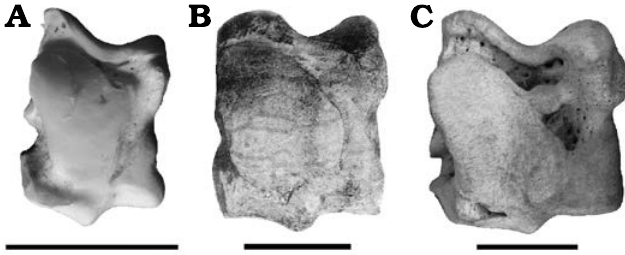
Fig. 8. Astragali of hippopotamids in plantar view. A . Choeropsis libe­ ri ensis (Morton, 1844) (RMCA n. RG35716), Holocene, specimen from zoo, Recent. B . Hexa protodon ? siculus (Hooijer, 1946) (Seguenza 1902: pl. 7: 9), late Mio cene, Gravitelli or Scirpi, Sicily, Italy. C . Hippopotamus amphibius Linnaeus, 1758 (RMCA n. RG508), Holocene, Zaire. Scale bar in B estimated according to the maximum height of the astragalus (97 mm) indicated by Seguenza (1902). Scale bars 50